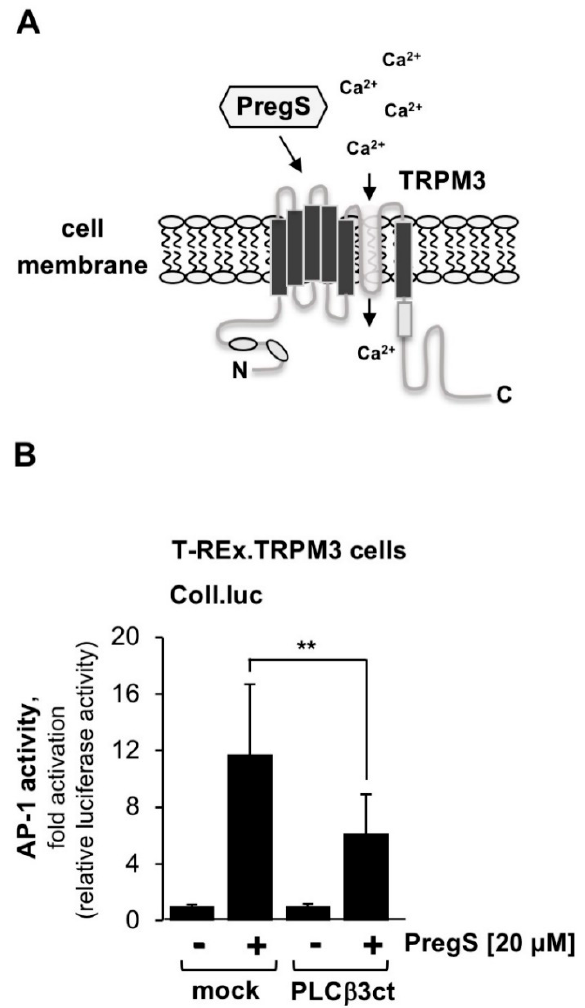
Figure 6. Expression of the C-terminal domain of phospholipase C β 3 blocks pregnenolone sulfate- induced signaling via TRPM3. ( A ) Modular structure of TRPM3. ( B ) T-REx-TRPM3 cells containing a chromatin-integrated Coll.luc reporter gene were infected with a lentivirus encoding either PLC β